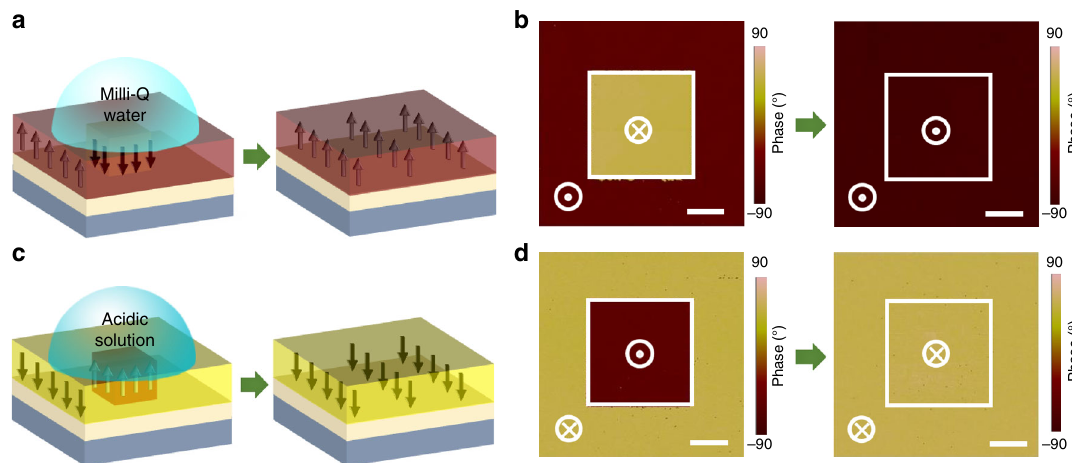
Fig. 1 Aqueous-solution-induced reversal of ferroelectric polarization. Schematics of BiFeO 3 (BFO) grown on a SrTiO 3 (STO) substrate with a (La,Sr)MnO 3 (LSMO) layer, switching from downward/upward to upward/downward after exposing the fi lms to Milli-Q water ( a ) and acidic solution ( c ). The arrows in the schematics represent the out-of-plane component of the polarization. The initial bipolar structure in the left panel of a and c was generated by scanning the surface with a tip under + 5 V and -5 V, respectively. b , d The corresponding piezoresponse force microscopy (PFM) images showing the polarization switching from downward/upward to upward/downward. Scale bar, 2 μ m ( b , d